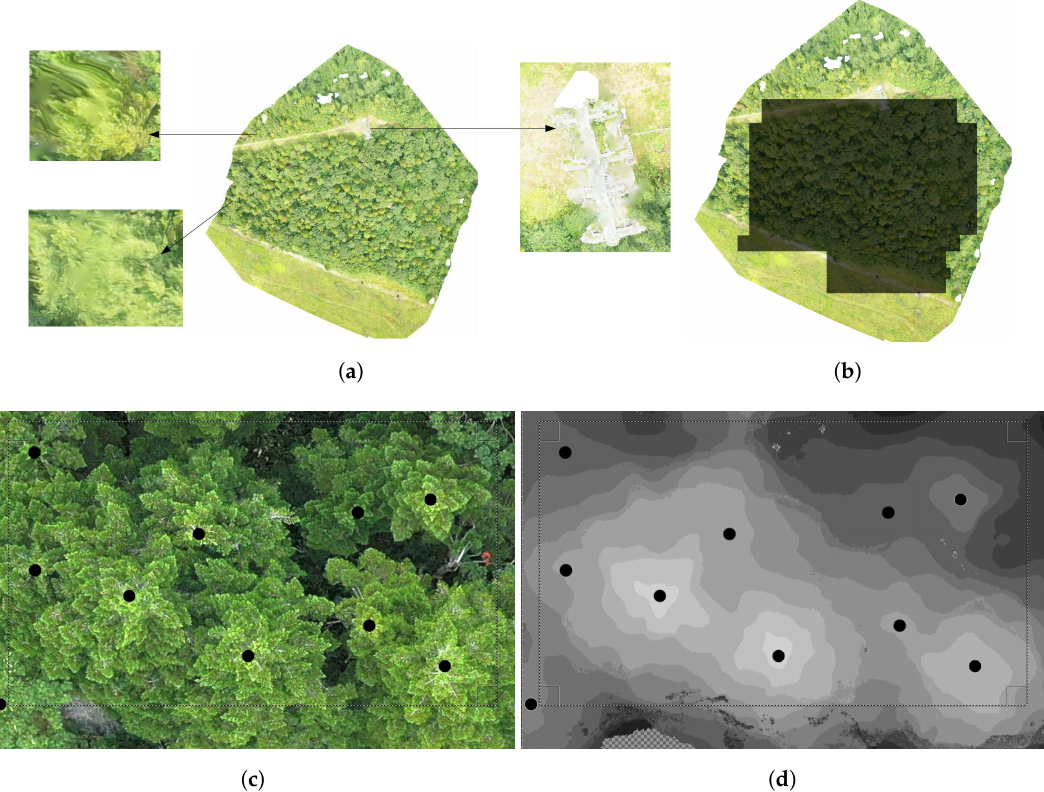
Figure 9. ( a ) artifact and distortion at the edge present in the orthomosaic; ( b ) ROI was applied to eliminate the artifacts and the distorted edge; ( c ) 10 Trees present in orthomosaics but ( d ) only 4 trees have clear distinct regions in